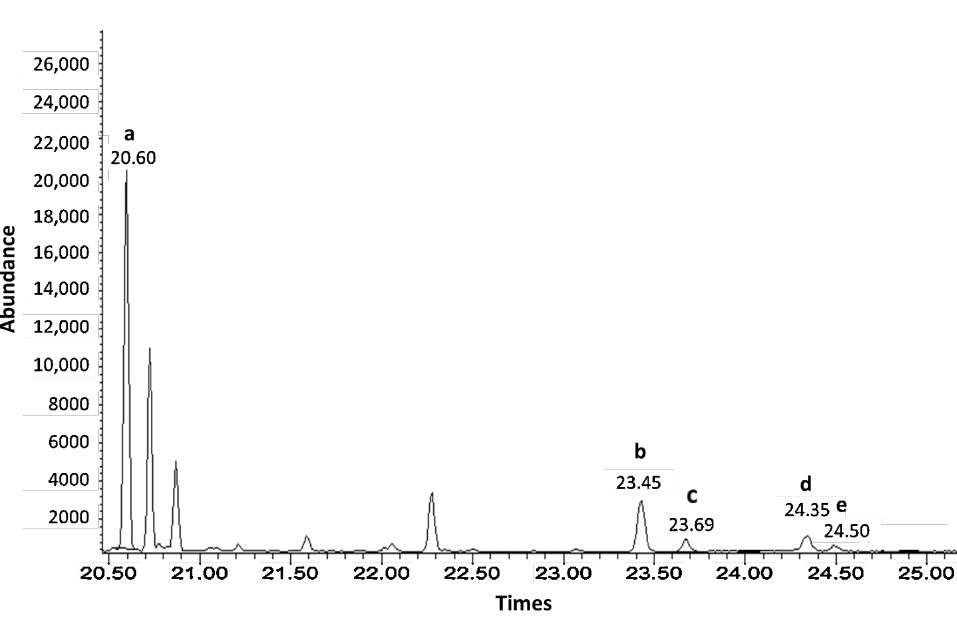
Figure 4. GC-MS chromatograms of the phytosterol contents from filter mud. The numbers on the peaks correspond to (a) cholestane as internal standard, (b) campesterol, (c) stigmasterol, (d) b-sitosterol, and (e) sitostanol.